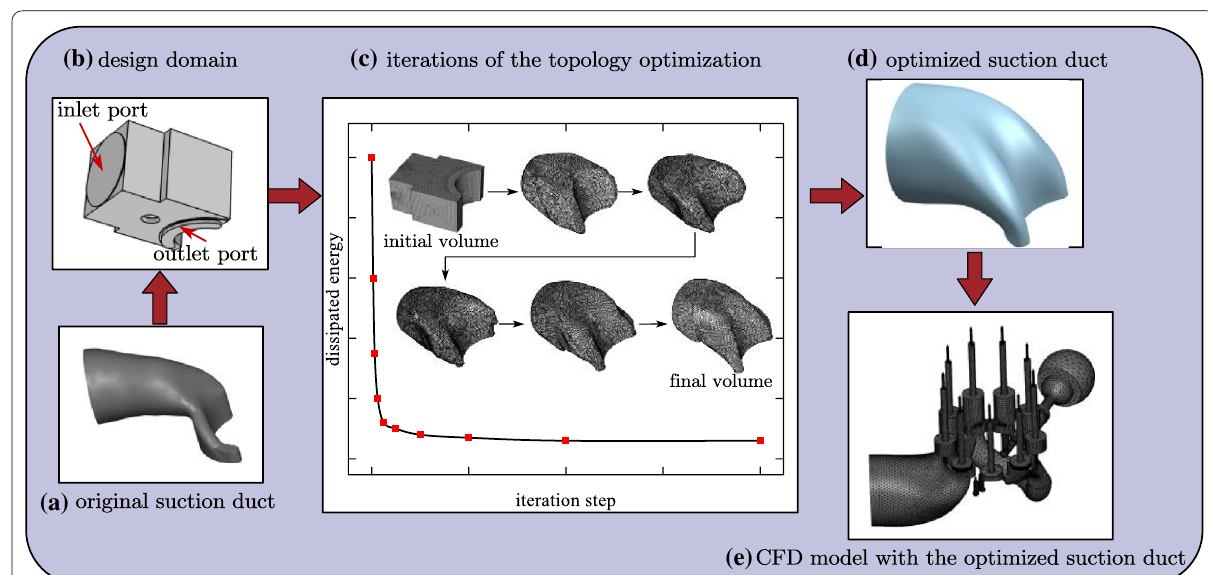
Figure 7 Process of the topology